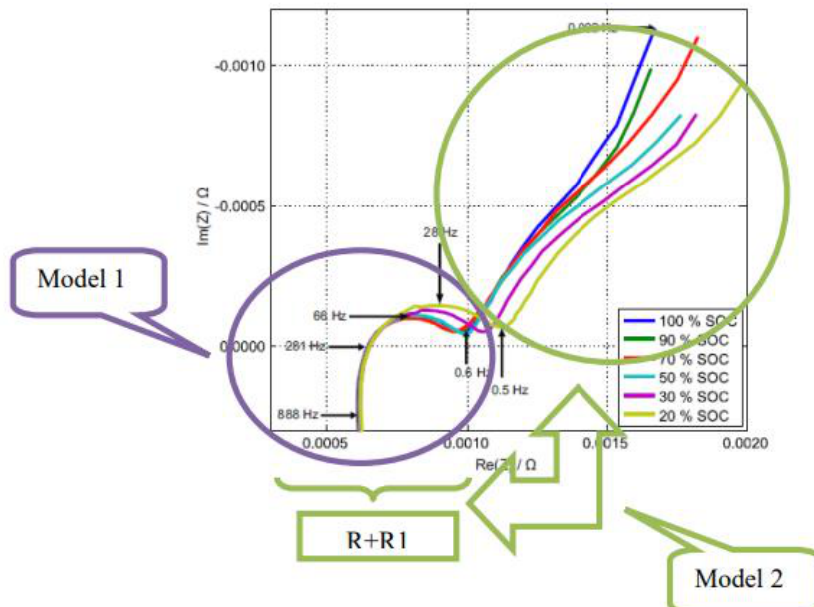
Figure 7. Impedance spectra of model 1 and model 2.